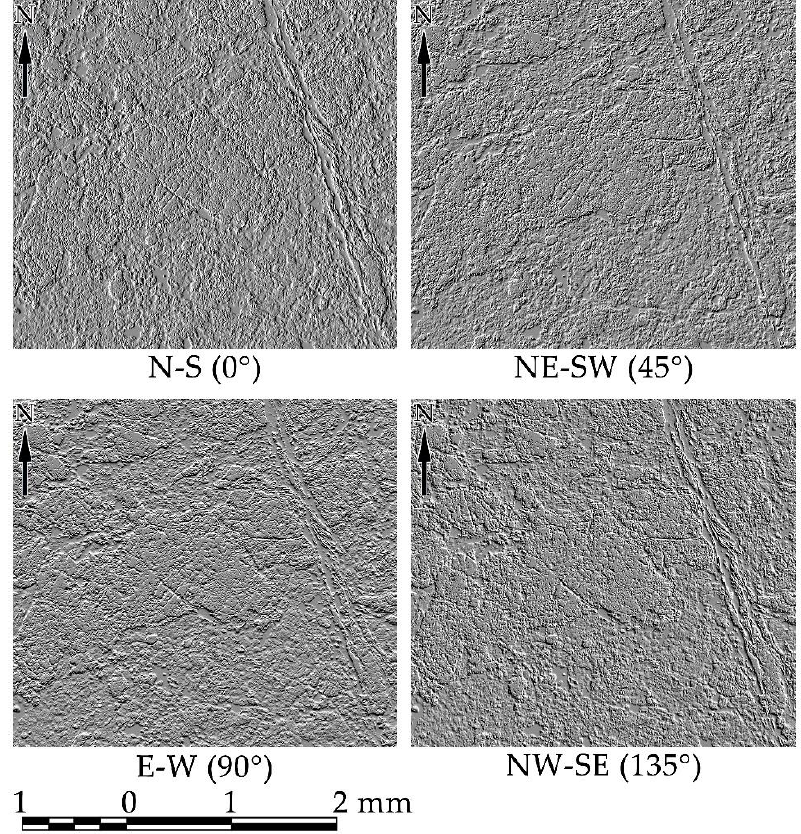
Figure 4. The result of filtering a part of the image of an oriented thin section with the Sobel operator in four principal directions. Table 4. Parameters used for the PCI Geomatica LINE